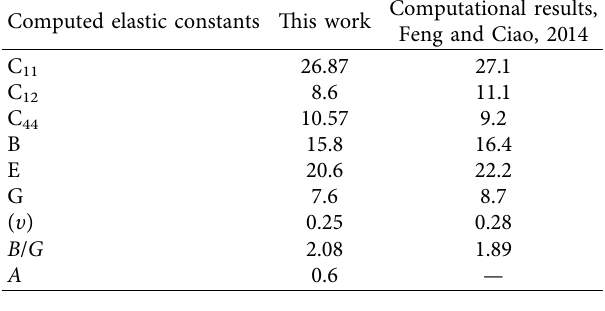
11 , C 12 , C 44 , bulk